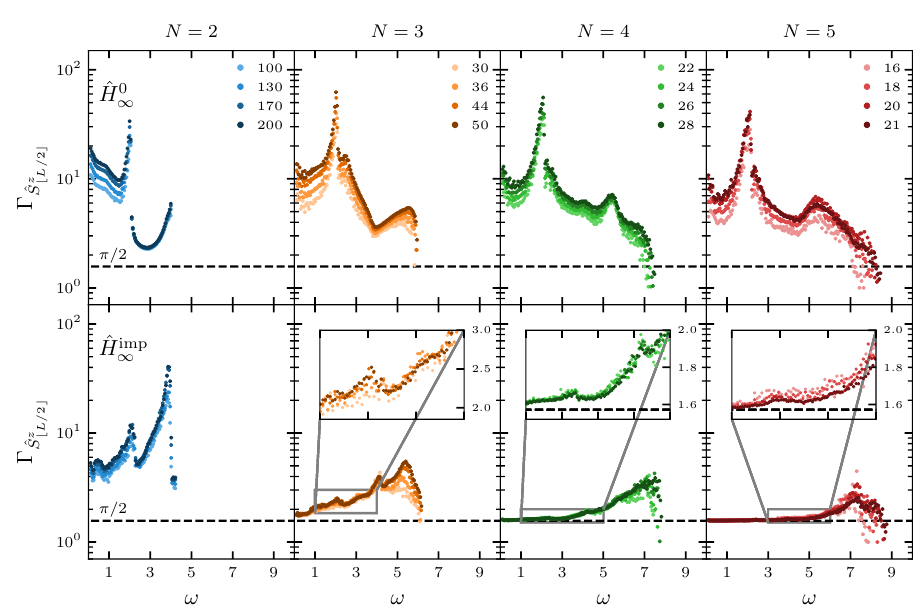
( ω ) for the integrable model ˆ H 0 (top row) and the single- Figure 3: Ratios Γ ˆ ∞ S z (cid:98) L / 2 (cid:99) impurity model ˆ H imp ∞ (bottom row) for different number of excitations (different columns). In each panel, larger system sizes are represented by darker colors (see legends). The insets zoom in into areas of interest and are on a linear scale. See ( ω ) was main text for the explanation of how Γ ˆ S z (cid:98) L / 2 (cid:99)